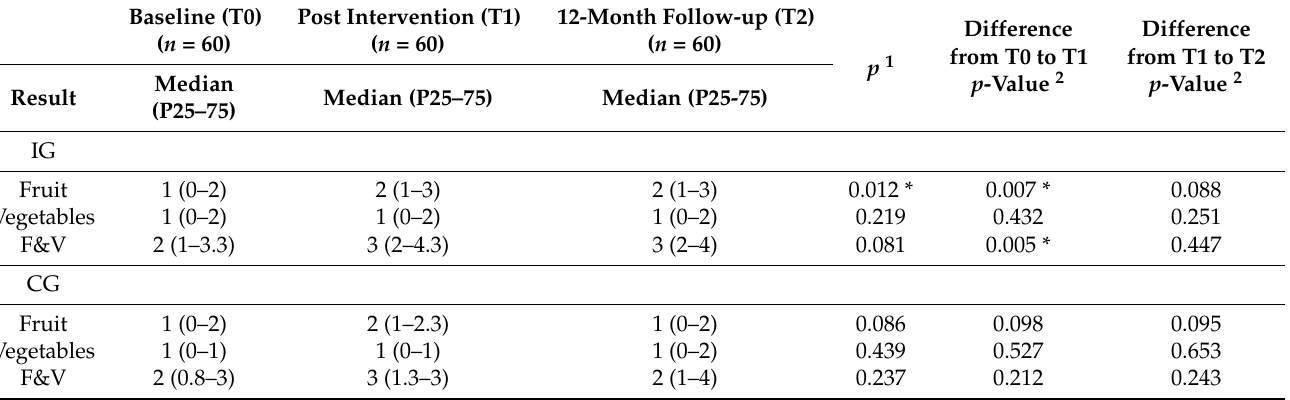
Table 4. Changes in the intake of F&V in each allocation group.